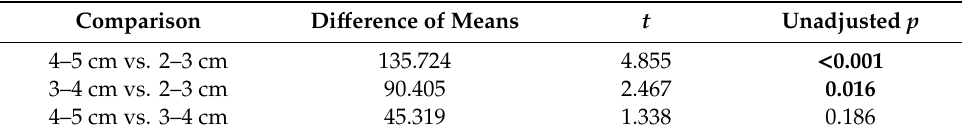
Table 2. Results of all pairwise multiple comparison procedures (Holm–Sidak method, overall significance level = 0.05) on size of D. ( Ctenodaphnia ) ephippia extracted from sediment core LCN10 04 / 1. Significant comparisons are highlighted in bold.